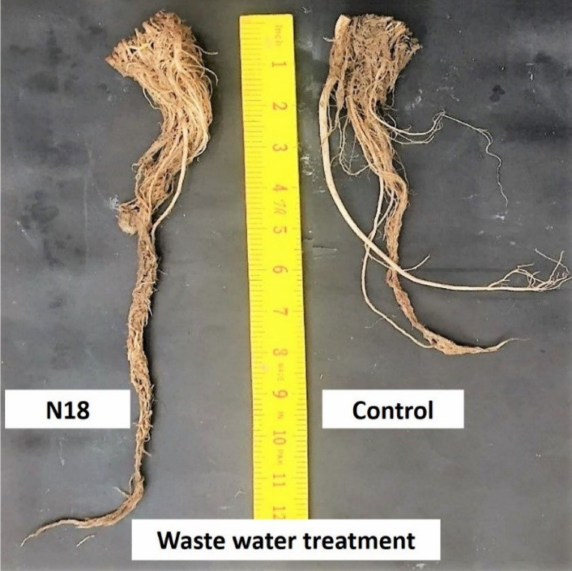
Figure 2. Effect of Pb-tolerant Bacillus strain and treated wastewater on root length of spinach in a pot